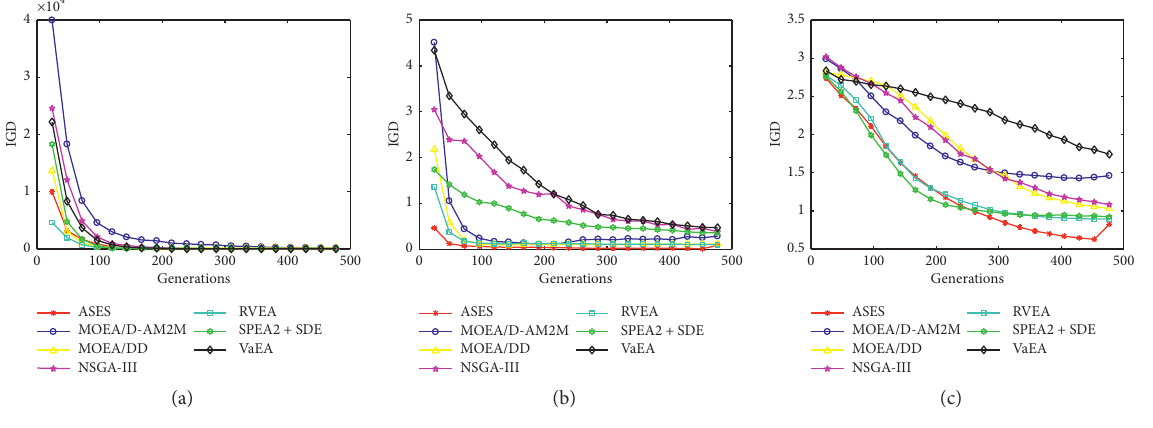
Figure 5: Convergence trend of six algorithms on 9-objective MaF4, MaF6, and MaF10.